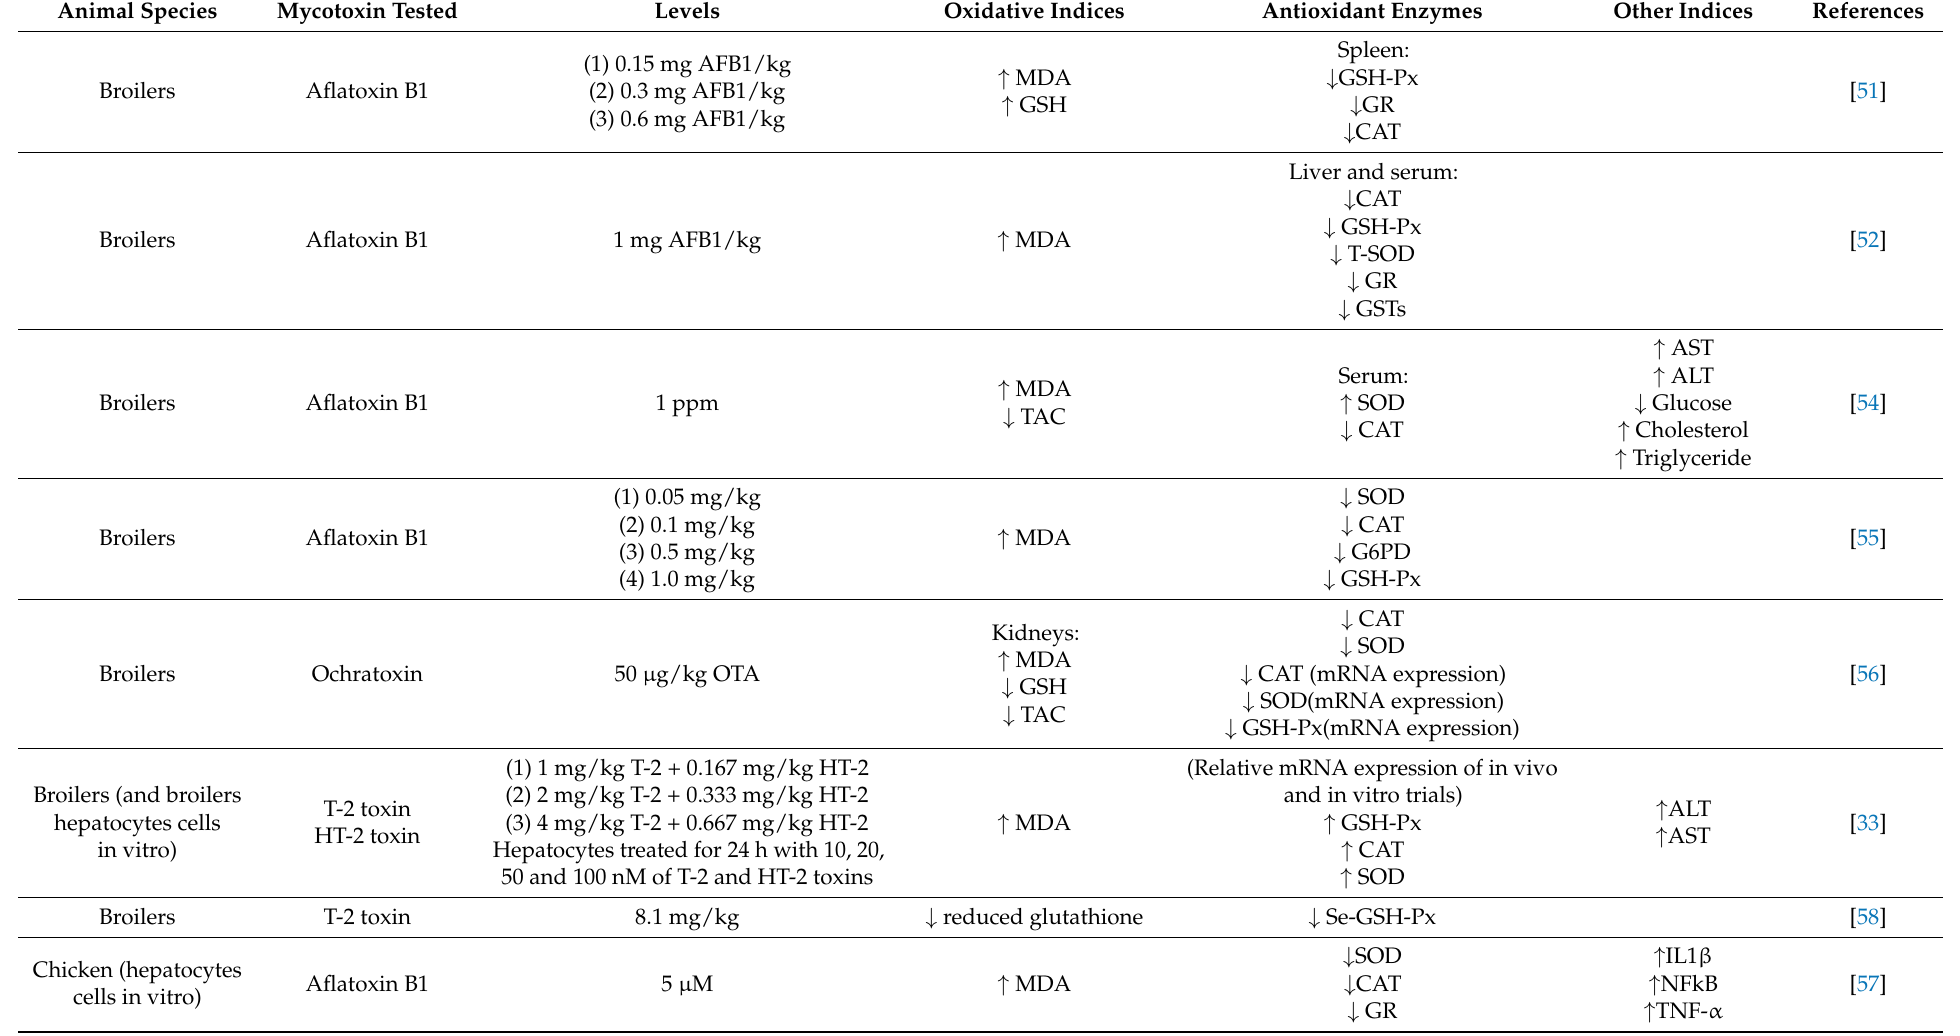
Table 3. Selected studies presenting the effects of mycotoxins on poultry and swine’s oxidative indices and antioxidant